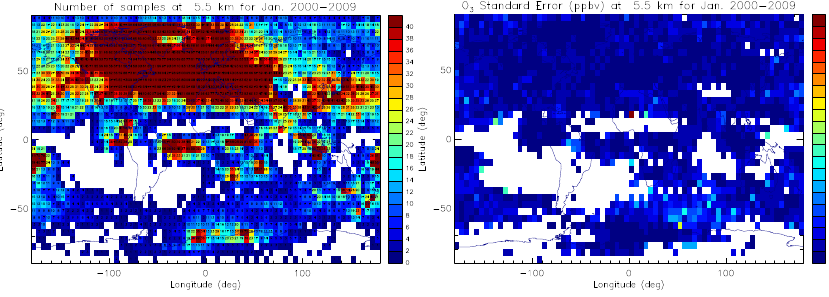
Figure 3: Number of data values and the standard error of the mean for each pixel average in a decadal average map for January in the mid-troposphere. The standard errors are generally of the order of a few ppbv (right figure), although where data density is low (left figure), they can be higher.